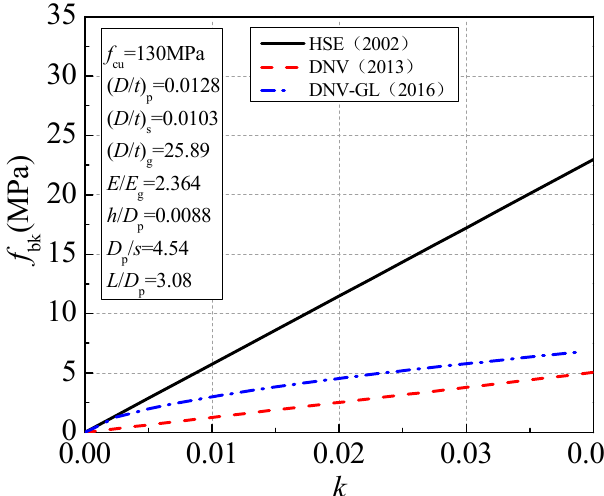
Figure 6. Relationship between f bk and radial stiffness factor ( k ).